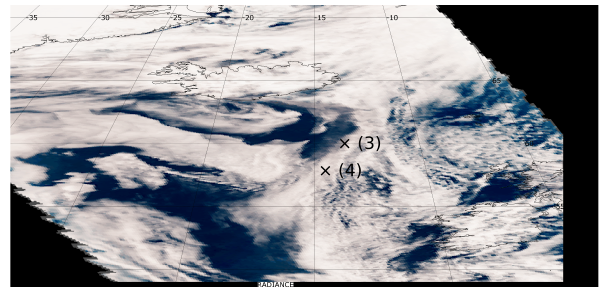
Fig. 9. Optical thickness retrieved at 0.865µm by POLDER over both ocean cloud-free pixels and cloudy pixels and lidar CALIOP trace (black line). The AOT values are relative to the PARASOL overpass on 6 May